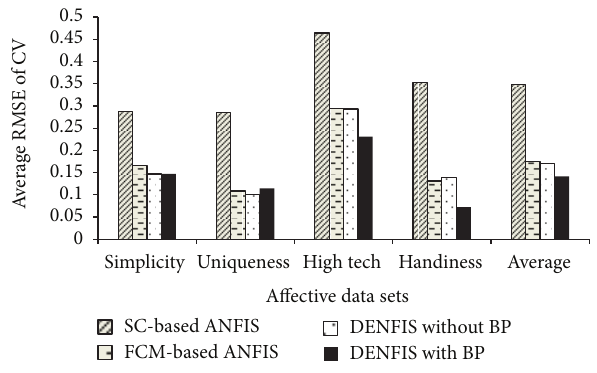
Figure 9: Histogram of the average RMSE of the NF models.